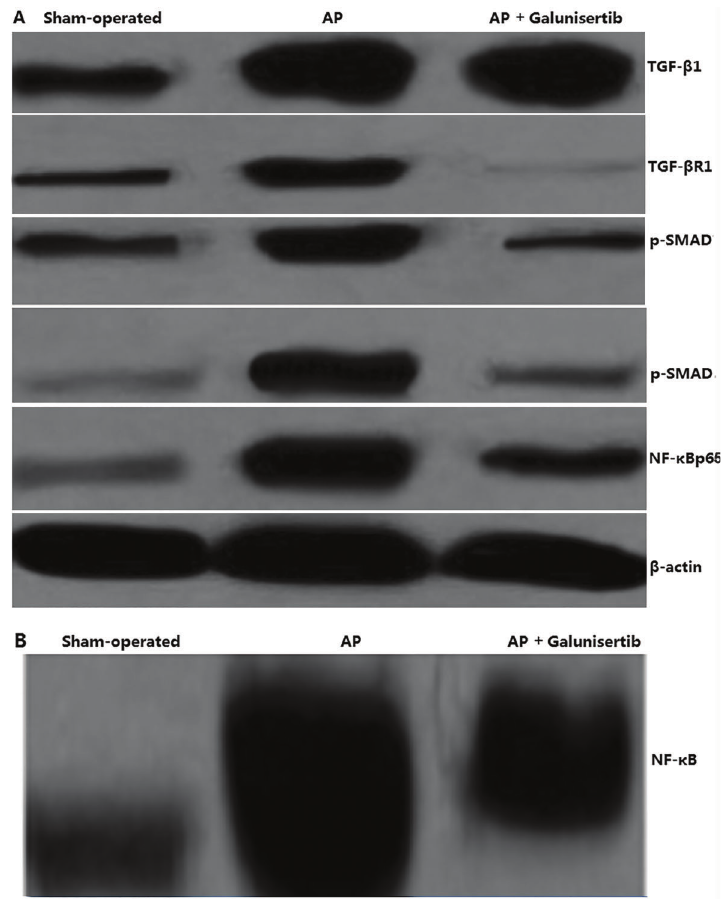
Figure 3. Effect of galunisertib on TGF- b 1 signal expression and NF- k B activity. Rats were sham- operated, acute pancreatitis-induced (AP) or AP + galunisertib 2 h after the induction of AP. After 48 h, pancreatic tissues were collected. A , Western blot assay for TGF- b 1, TGF- b R1, p-Smad2/3 and NF- k Bp65 expression. B , EMSA assay for NF- k B activity.